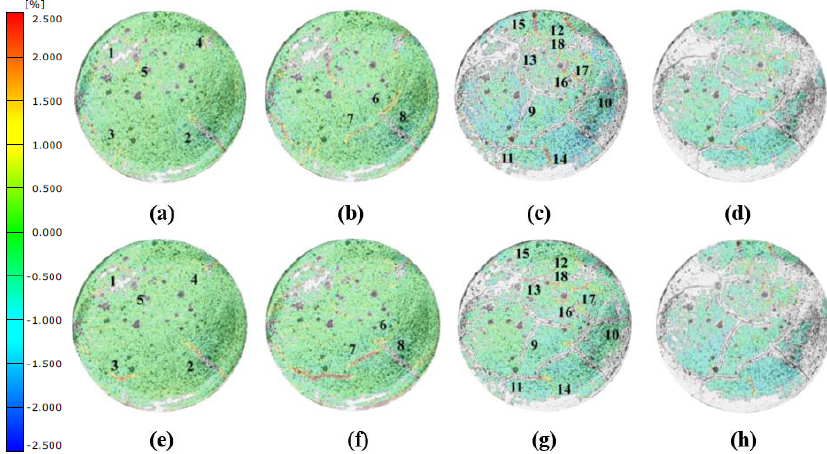
Figure 6. Strain of plain cemented soil in the early times: ( a ) ε x -50 min; ( b ) ε x -60 min; ( c ) ε x -80 min; ( d ) ε x -100 min; ( e ) ε y -50 min; ( f ) ε y -60 min; ( g ) ε y -80 min; ( h ) ε y -100 min.